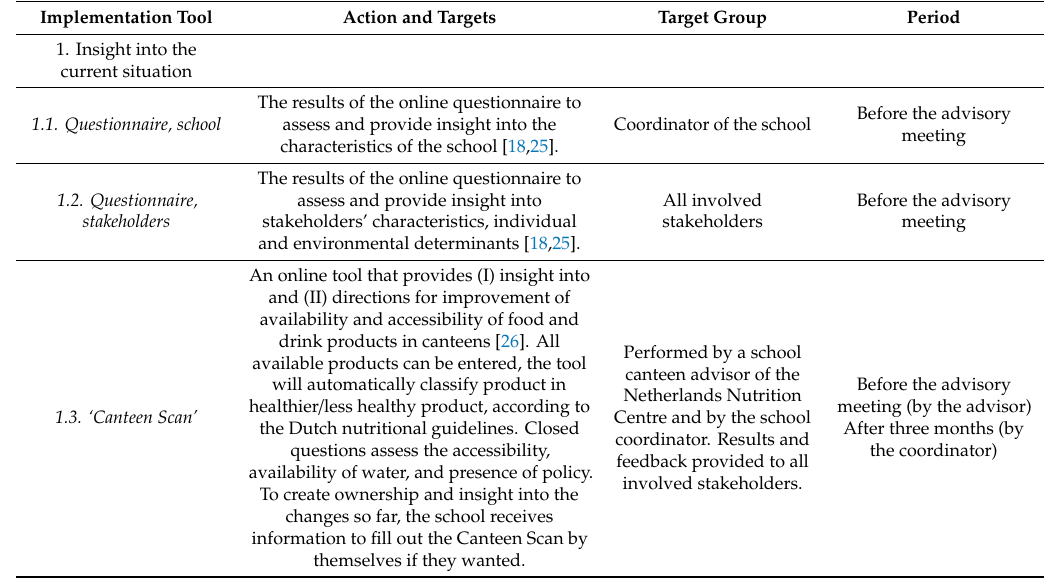
Table 1. Description of the implementation plan to implement the Guidelines for Healthier Canteens a